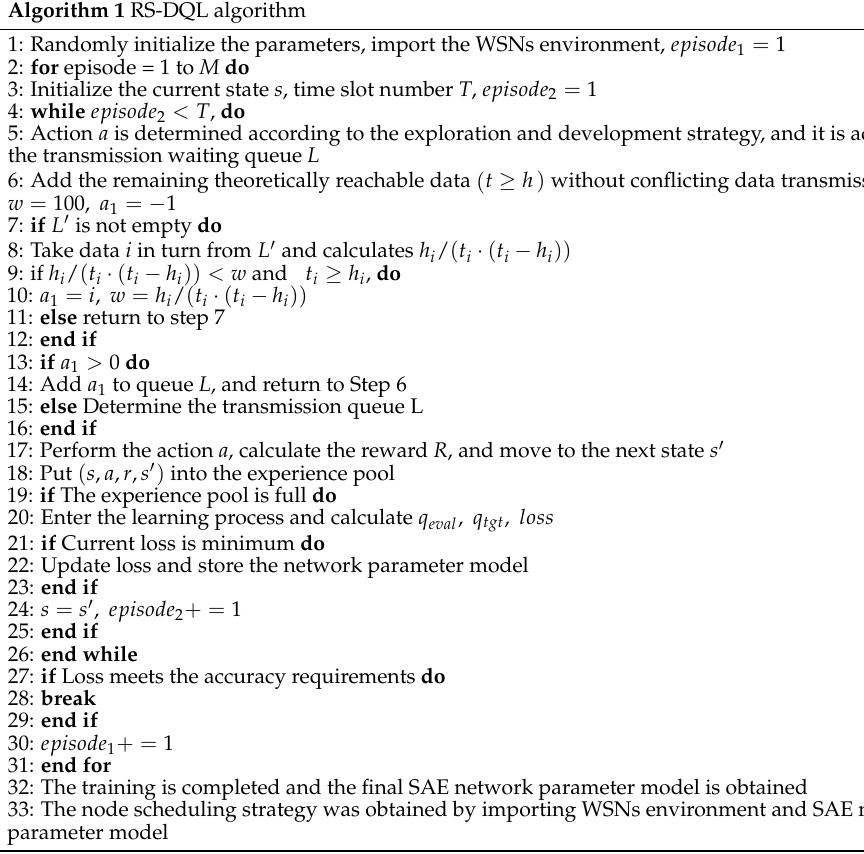
Algorithm 1 RS-DQL